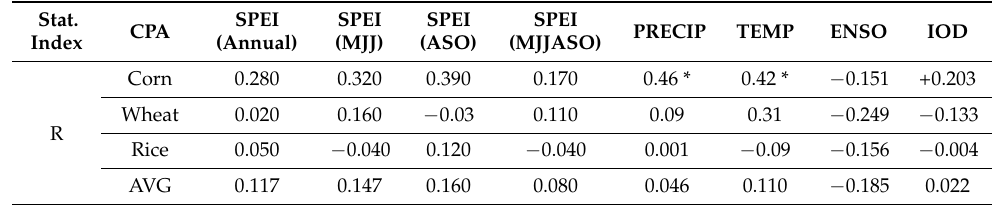
Table 3. Correlation coefficients between crop production anomalies (CPA) and climate and telecon- nection variables from